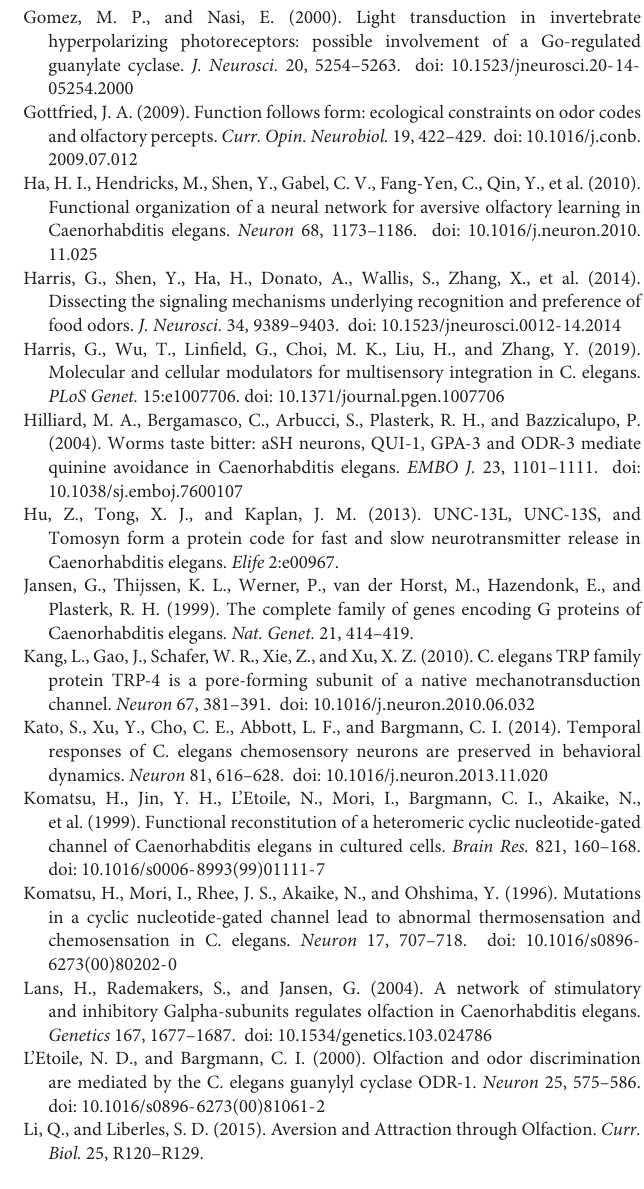
Supplementary Figure 2 | IAA induced responses in AWC and AWB neurons. Related to Figure 1 . (A) A schematic drawing of the calcium imaging and electrophysiological recording of odorant-induced responses in C. elegans olfactory neurons. (B) Representative traces show olfactory currents from AWC neurons induced by 0.01% Bu (AWC ON ), 0.01% Bz (AWC ON and AWC OFF ), and 0.01% Pd (AWC OFF ). Bz, benzaldehyde. Pd, 2,3-pentanedione. Bu, butanone. (C) 1% IAA-induced currents in AWC neurons in unc-13(e51), unc-13(e1091), unc-31(e928) and unc-18(e81) mutants were equal to that in wild-type animals. n ≥ 4. (D) IAA-induced currents in AWB neurons in unc-13 mutants. n ≥ 7. (E,F) 0.01% IAA-induced calcium responses in AWB neurons in unc-13(e51) and unc-31(e928) mutants. n ≥ 7. For patch-clamp recording, the cell membrane potential was voltage-clamped at –70 mV. Error bars: SEM. N.S., not significant. Supplementary Table 1 | Biophysical properties of IAA-induced currents from AWC and ASH neurons. Related to Figure 1 . The rise times and decay times were obtained from 10 to 90% of the peak amplitude. Voltage: –70 mV. n ≥